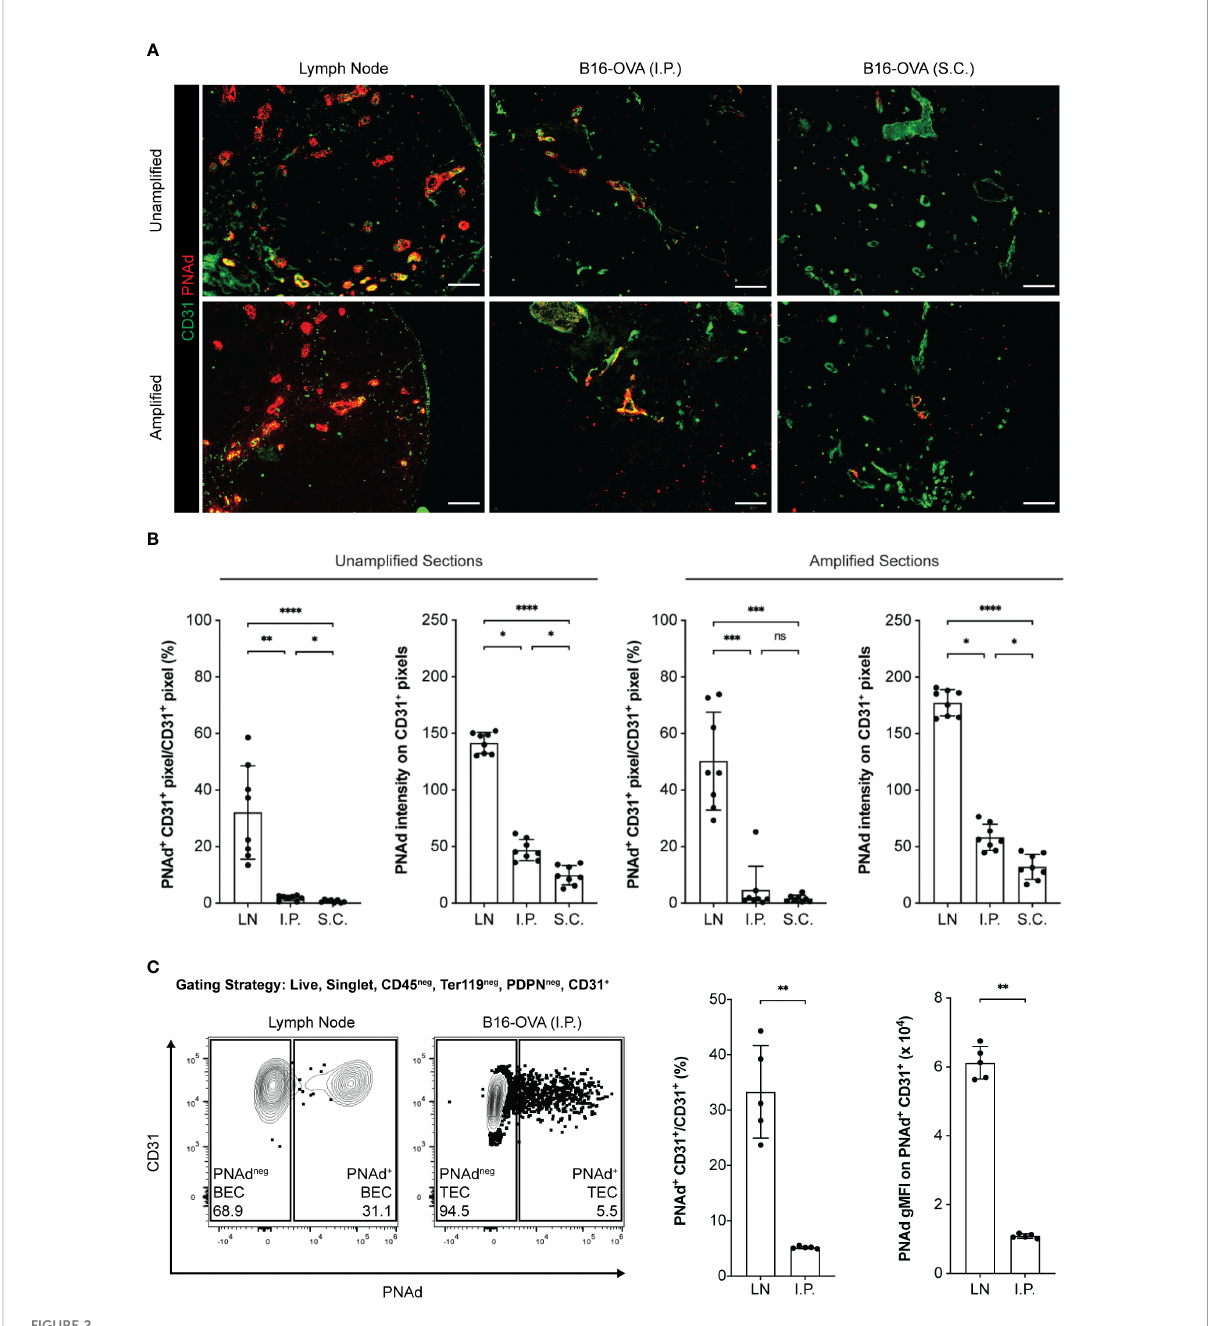
FIGURE 2 PNAd expression is signi fi cantly lower on tumor-associated endothelium than on lymph node endothelium. C57BL/6 mice were S.C. or I.P. injected with B16-OVA cells. Tumors were harvested 14 days later. LN were harvested from non-tumor-bearing mice. Resected tissues were prepared for IF microscopy (A, B) or fl ow cytometry (C) as described in Methods. (A) Representative images of unampli fi ed and tyramide signal ampli fi ed LN and tumor sections stained with indicated markers. Scale bar = 100 µm. (B) Quantitative image summary data for unampli fi ed and ampli fi ed tissue sections. PNAd percentages and pixel intensities were calculated on a CD31 + mask. Data represents two experiments, n = 8 sections per group. (C) Representative fl ow cytometry plot, percentages, and gMFI intensities of PNAd on CD45 neg Ter119 neg PDPN neg CD31 + endothelial cells in CD45 + depleted LN and I.P. tumors suspensions. PNAd gMFIs were calculated on cells gated above the fl uorescence minus one (FMO) control. Data represents one experiment, n = 5 LN or tumors per group. (B, C) Results are mean standard deviation (SD) analyzed by unpaired Welch ’ s t-test. ns: p>0.05, *p<0.05, **p<0.01, ***p<0.001, and